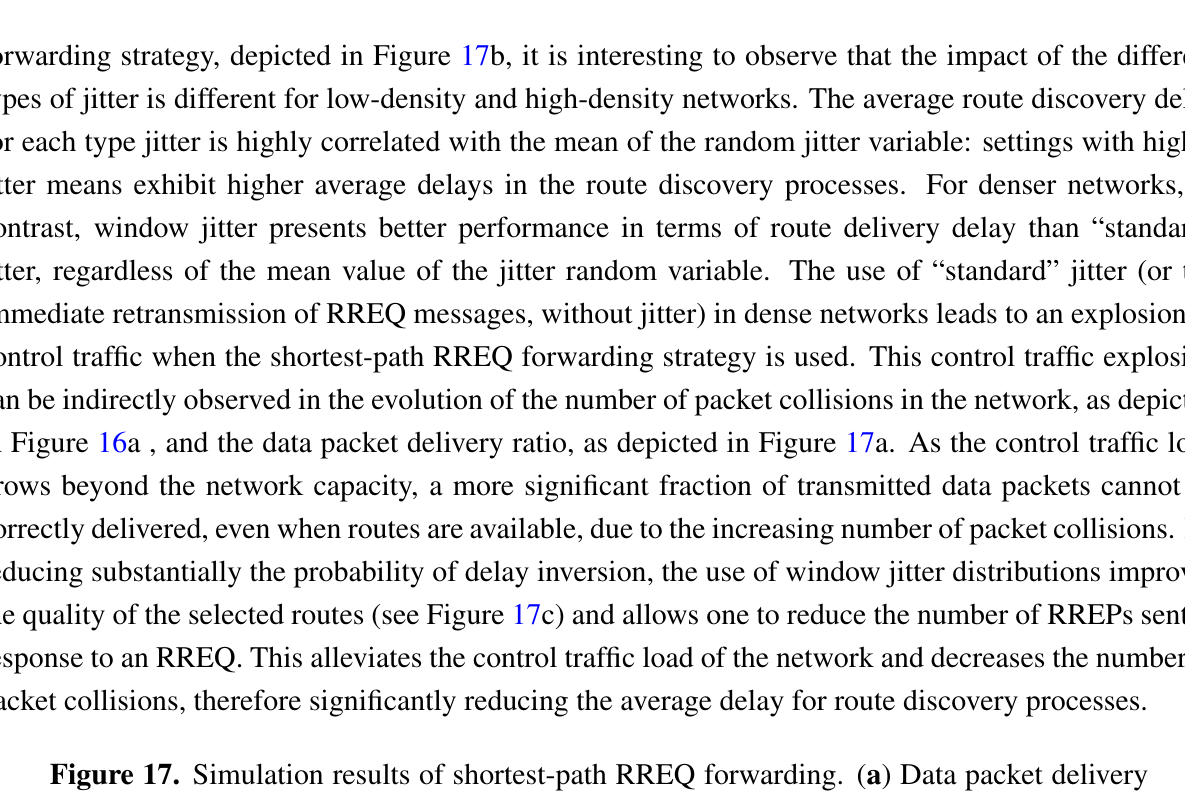
Figure 17. Simulation results of shortest-path RREQ forwarding. ( a ) Data packet delivery ratio; ( b ) The average route discovery delay; ( c ) Average path